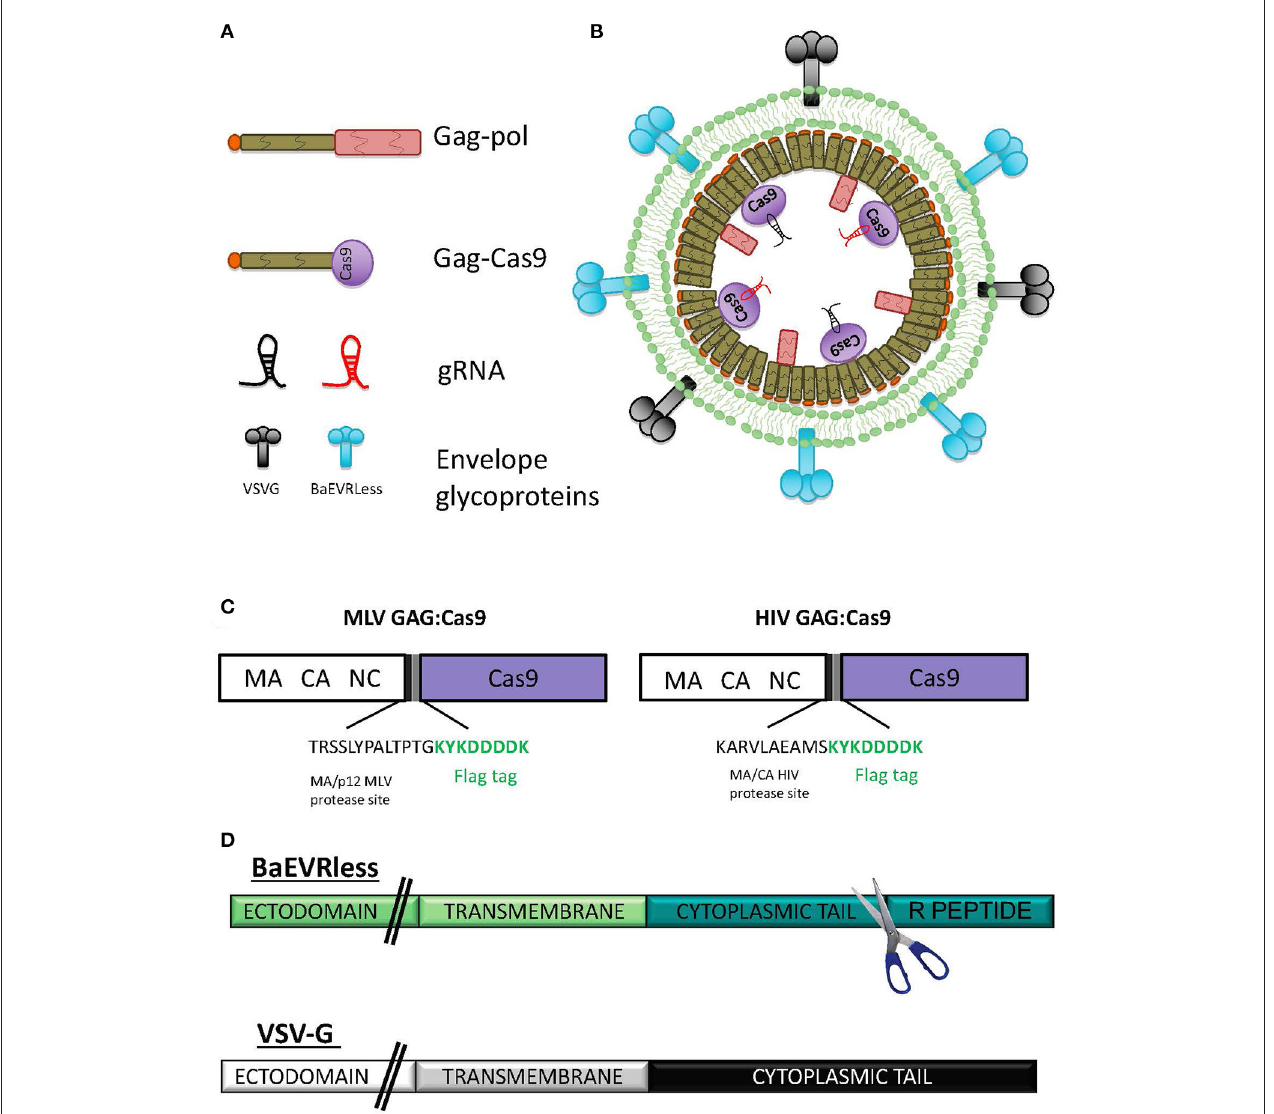
FIGURE 1 | Schematic presentation of nanoblades. (A) Representation of the different components of the nanoblades: gag-pol, the gag-Cas9 fusion protein, the different gRNA and the envelope glycoproteins (gps), (B) Schematic representation of the assembly of a nanoblade particle, (C) Scheme of the MLV GAG:Cas9 fusion (left) and HIV GAG:Cas9 fusion (right) indicating the inserted MLV or HIV protease site followed by a Flag tag. (D) Schematic representation of the mutant BaEV envelope gp (BaEVRless) and the VSV-G envelope gp. The R-peptide of the cytoplasmic tail of BaEVwt was deleted resulting in the BaEVRLess mutant